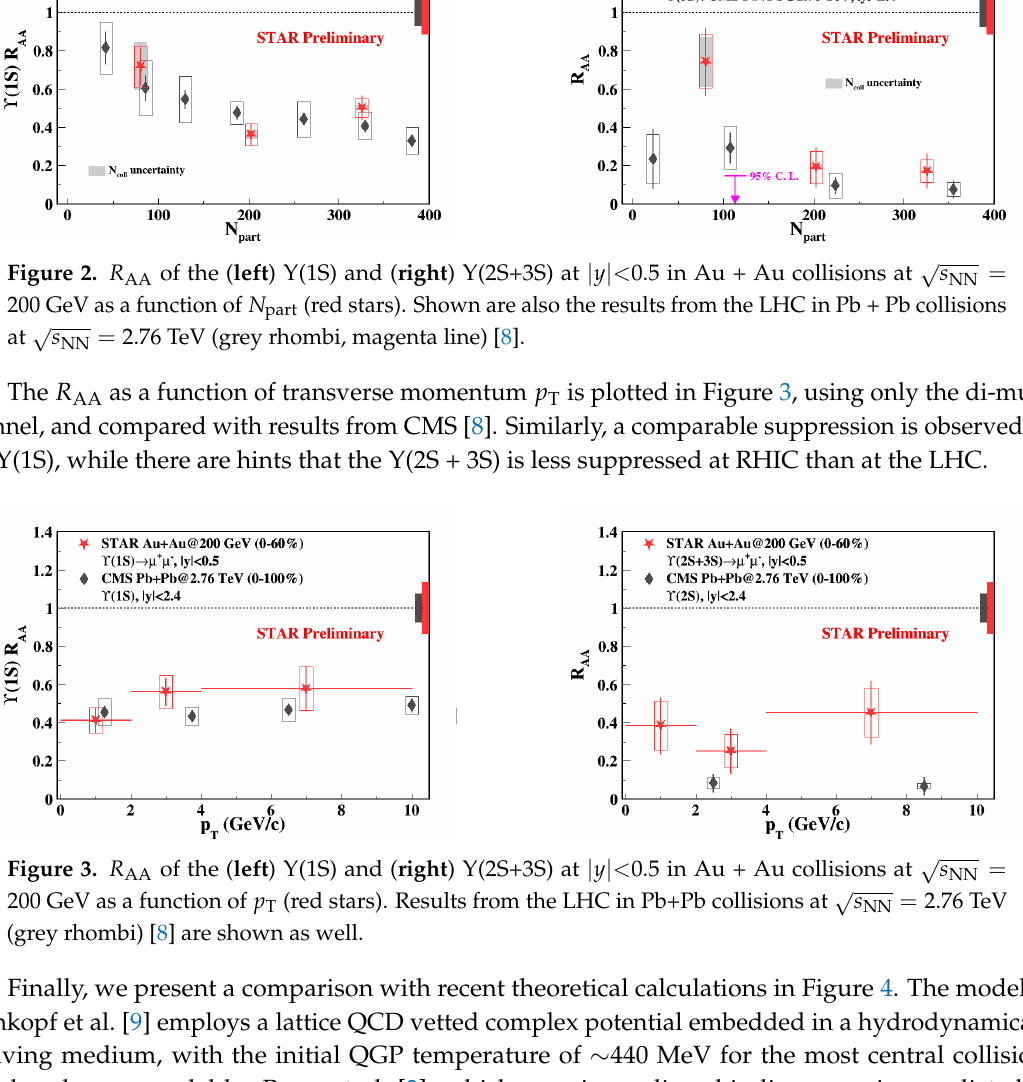
Figure 3. R AA of the ( left ) Υ (1S) and ( right ) Υ (2S+3S) at | y | < 0.5 in Au + Au collisions at 200 GeV as a function of p T (red stars). Results from the LHC in Pb+Pb collisions at (grey rhombi) [8] are shown as